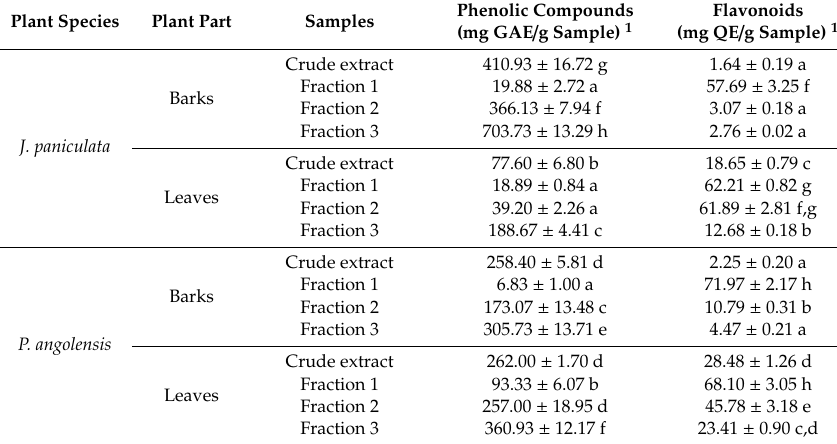
Table 1. Total phenolic compounds and flavonoids